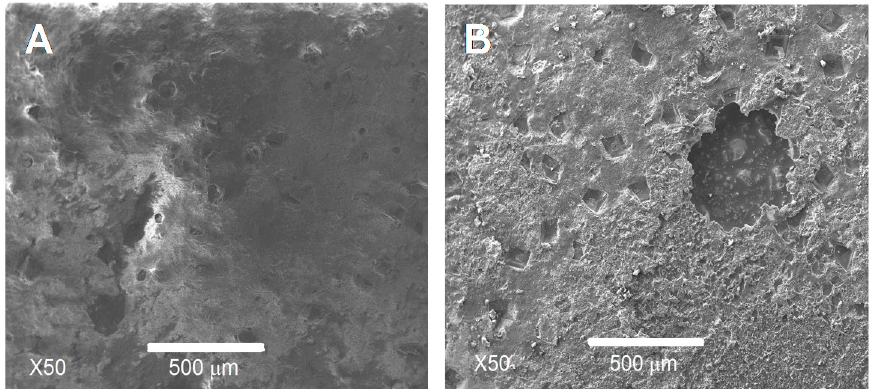
Figure 5. SEM images of the surface resulting from the adhesion test for samples with and without coating: ( A ) HAp coated sample and ( B ) uncoated sample.